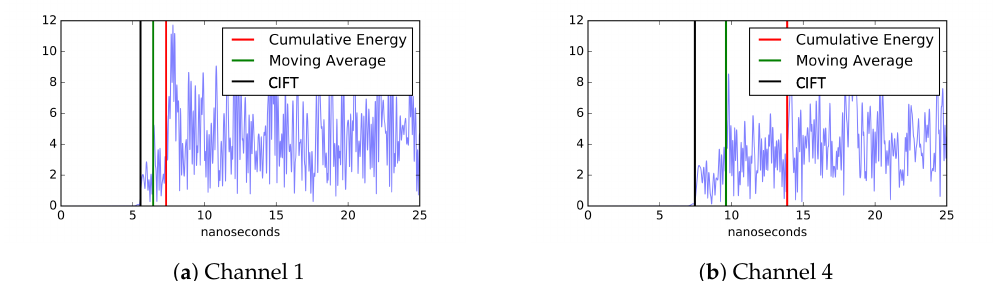
Figure 10. Signal arrival time of a simulated PD event in DL23. The horizontal axis is time and the vertical axis is the measured voltage (from FDTD simulation). In all cases, CIFT is able to identify the signal arrival time close to the known start time of 5 ns. In a low SNR case, shown in ( b ), the arrival time computed by the cumulative energy method is nearly 10 ns later than the actual signal start time, while the error of CIFT is only about 3